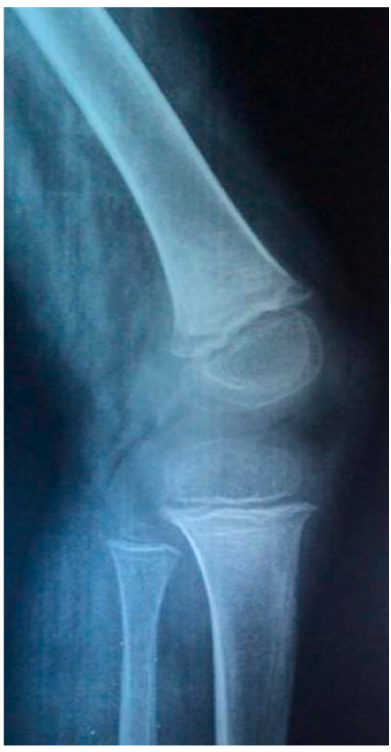
Figure 2. Lower limb X-Ray showing typical features such as radio-dense band (Frenkel line), marginal spur formation.